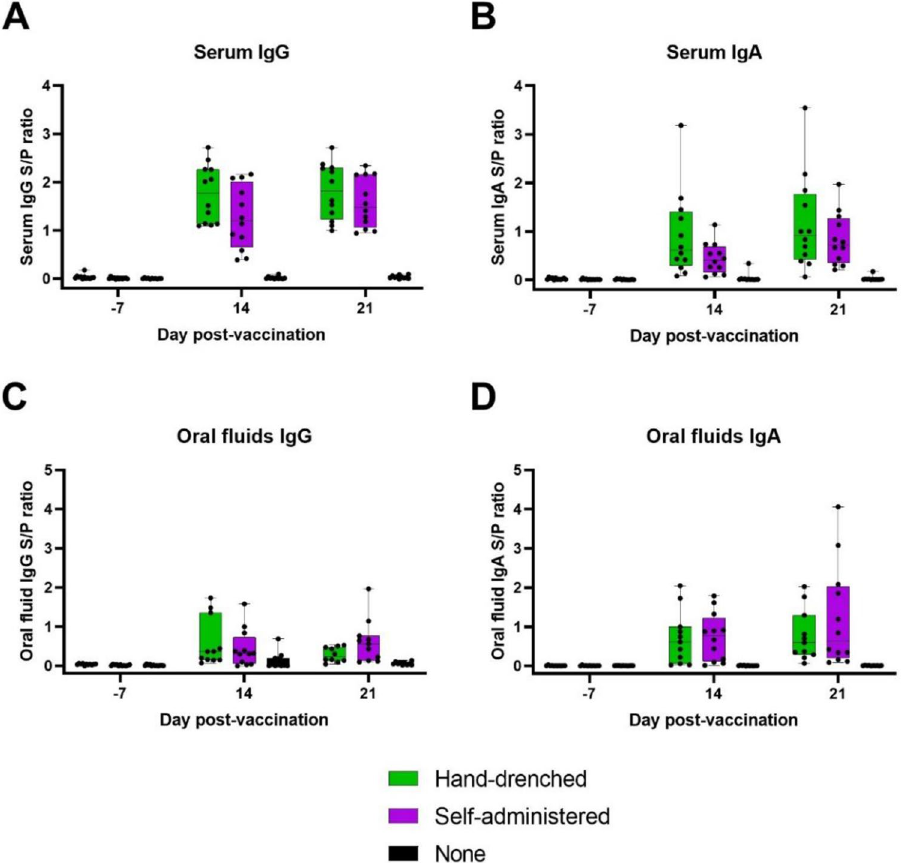
Figure 2. Graphic representation of the data showing individual values and the variation within treatments. Note that Control pigs (None) have little or no IgG or IgA at all times. Note also that IgG and IgA levels are statistically similar for pigs that were hand drenched or self-administered the Salmonella vaccine. Graphs represent the days peri-vaccination (days -7, 14 and 21) with panel A serum IgG, B serum IgA, C oral fluids IgG and D oral fluids